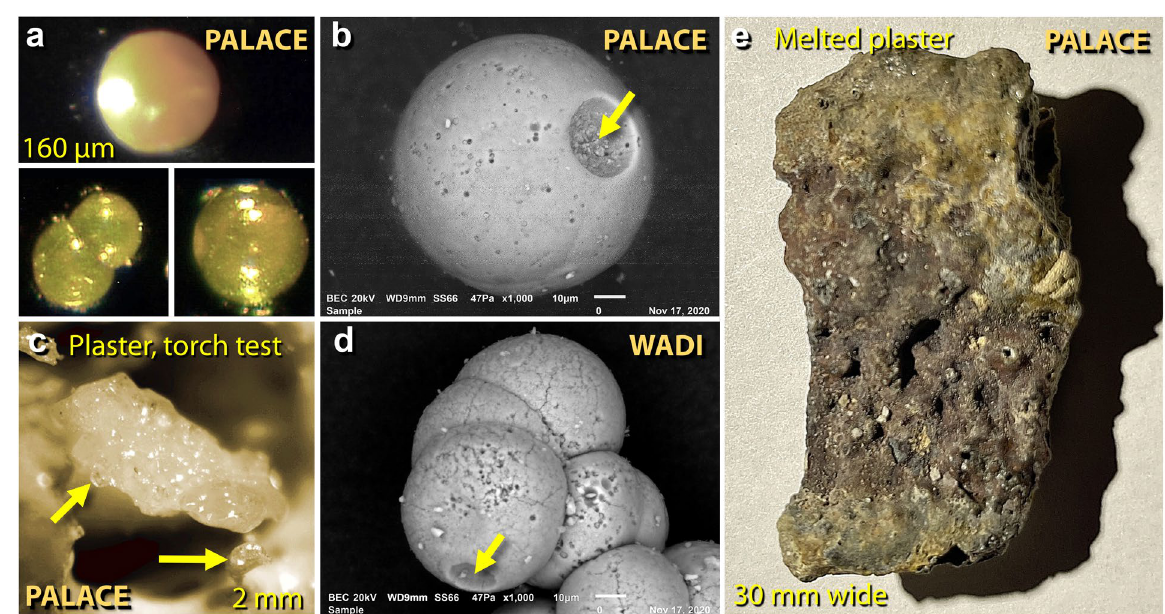
Figure 29. Images of calcium carbonate spherules and melted plaster from TeH. ( a ) Photomicrographs of translucent, amber-colored CaCO 3 spherules from the destruction layer in the palace. ( b ) SEM image of 83-µm carbonate spherule with impact or outgassing crater at arrow. ( c ) Photomicrograph of ~ 2-mm-wide piece of partially melted palace plaster from oxygen/propylene torch test, showing incipient melting at 1500 °C. Arrows point to hemispheric droplets emerging as spherules. ( d ) 142-µm cluster of 8 carbonate spherules with apparent impact or outgassing crater at arrow. ( e ) 64 × 30 mm piece of melted plaster that broke off the palace wall and became melted. It is composed only of calcium, carbon, and